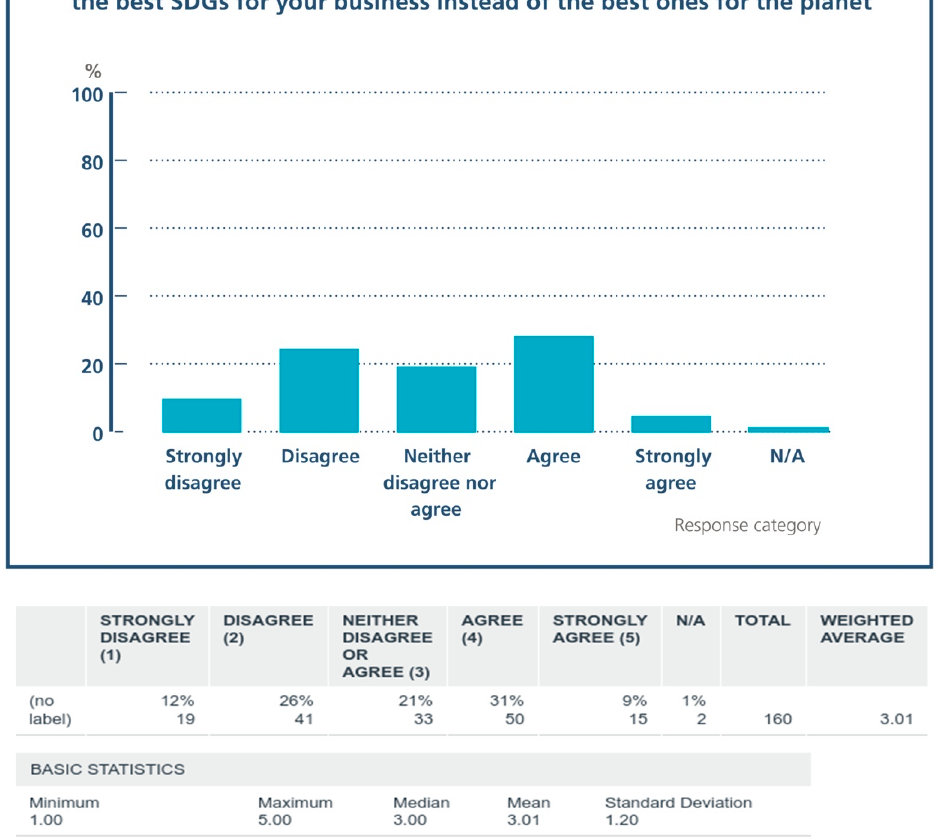
Figure 10. Response to Question 3: Do commercial realities dictate the SDGs you